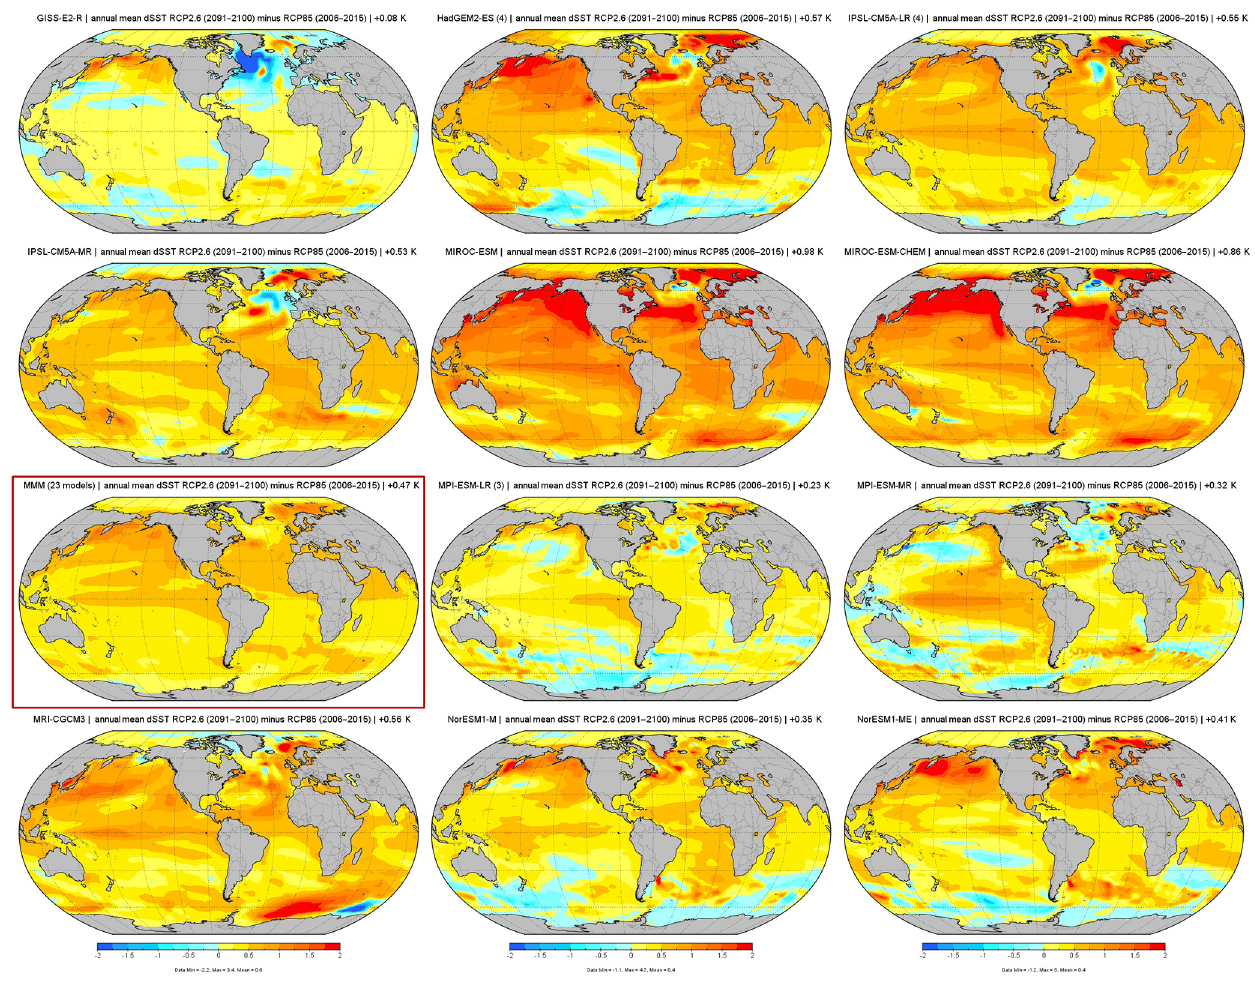
Figure A2. As previous but for the second set of 12 individual